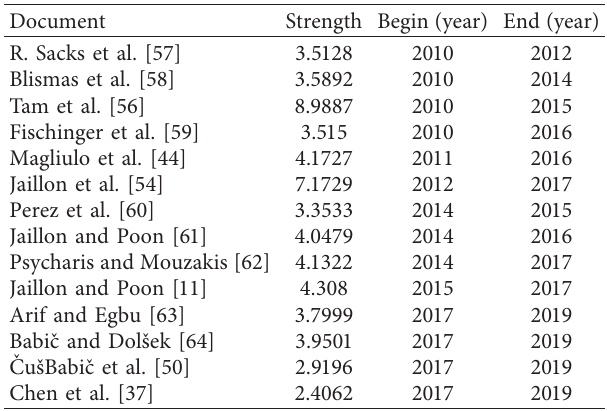
Figure 8: Document co-citation network. Table 10: Top 14 documents co-citation with the strongest citation bursts in each corresponding